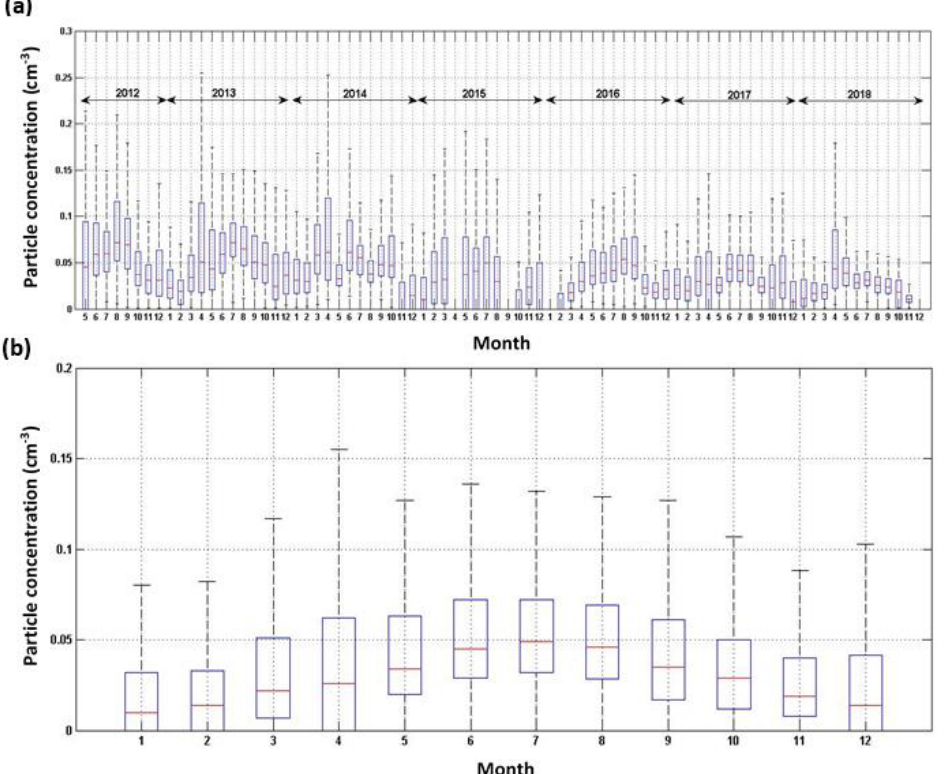
Figure 9. ( a ) Evolution of the total particle concentration (cm − 3 ) of diameters between 1.150 and 4.5 µ m measured by the OPC over the entire period; ( b ) seasonal median variations of this parameter. Red lines represent the median value, bottom and top sides of the boxes symbolize the 25th and 75th percentile, respectively. The length of the whiskers represents 1.5 × interquartile range which includes 99.3% of the